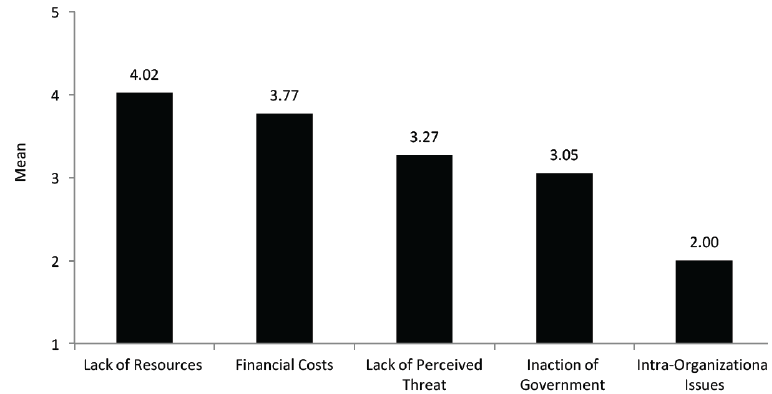
Figure 2. Mean scores for factors influencing natural resource professionals actions regarding climate adaptation and mitigation actions where 1 = not at all important, 2 = slightly important, 3 = somewhat important, 4 = important, 5 = very important.